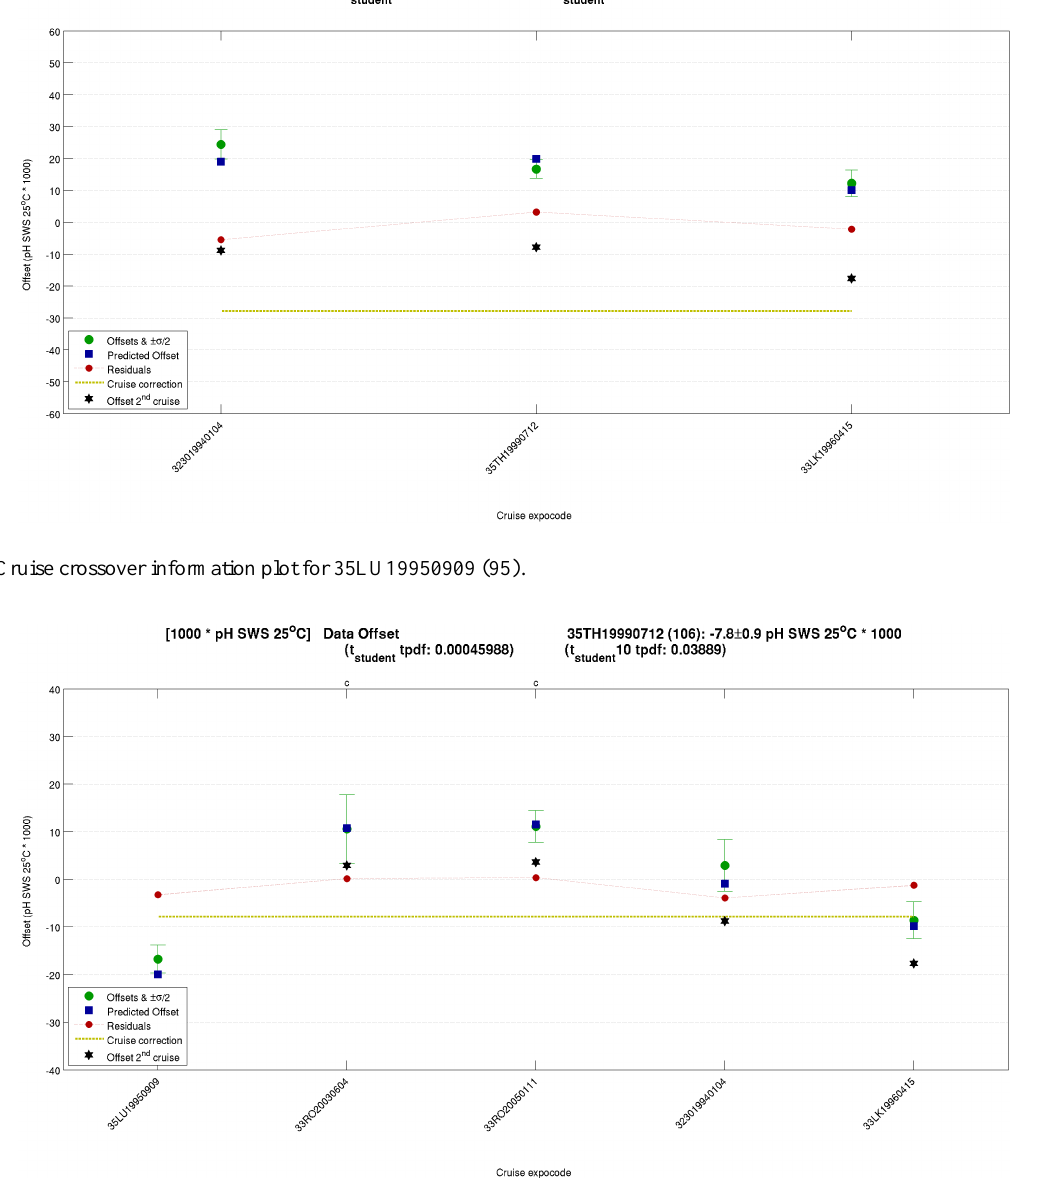
5.12 Cruise 35LU19950909 (95) (Fig.